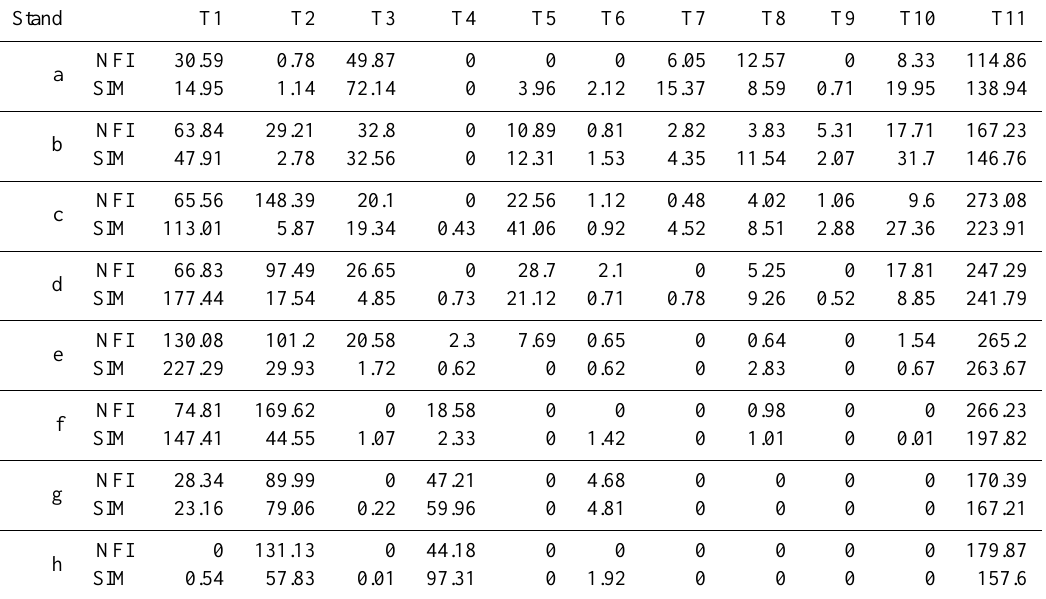
Table D5. Forest biomass of the NFI3 inventory and LPJ-GUESS results for the simulation year 2006 (all in tha − 1 ). See Table D4 for